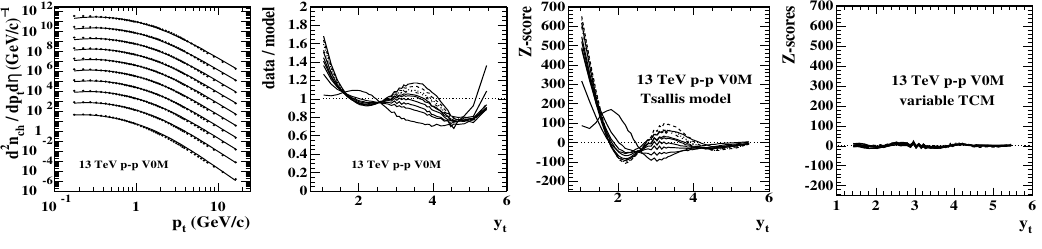
Figure 5: First: Tsallis model (solid) vs V0M spectra (points). Second: Tsallis data / model ratios. Third: Corresponding Z-scores. Fourth: Z-scores for variable TCM.